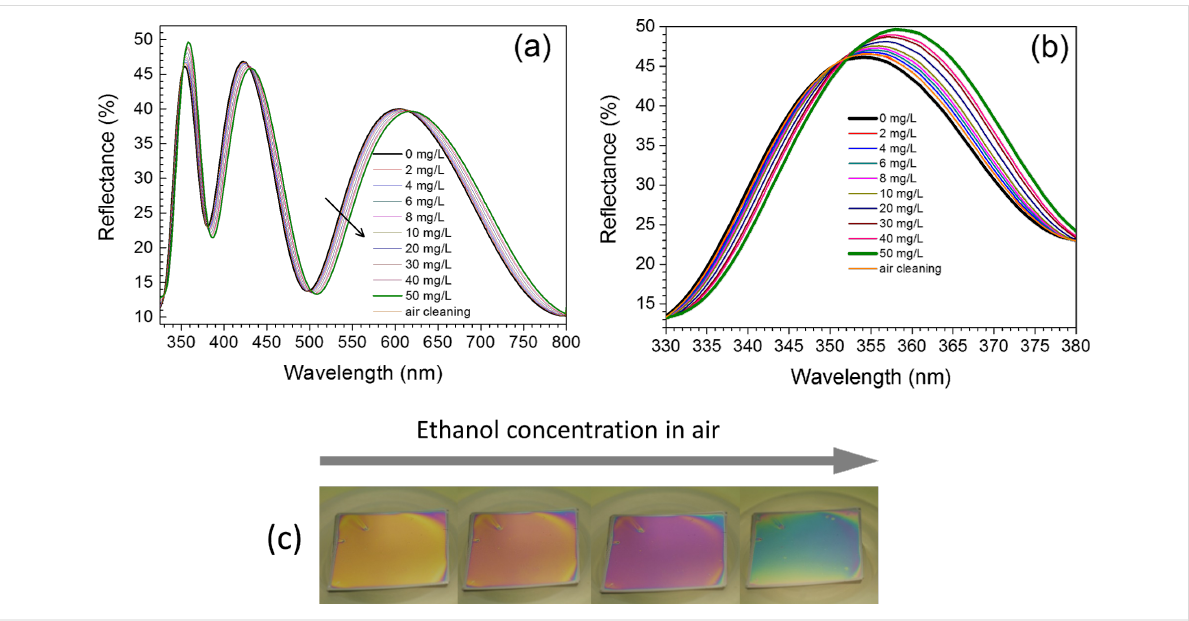
Figure 4: (a) UV–vis reflectance spectra of the film exposed to different ethanol concentrations and cleaned sample. (b) Short-wavelength region of the previous spectrum at larger scale; (c) Change of the color of the film with increase of the ethanol concentration (no ethanol, ethanol/water 10:90, ethanol/water 50:50, ethanol/water